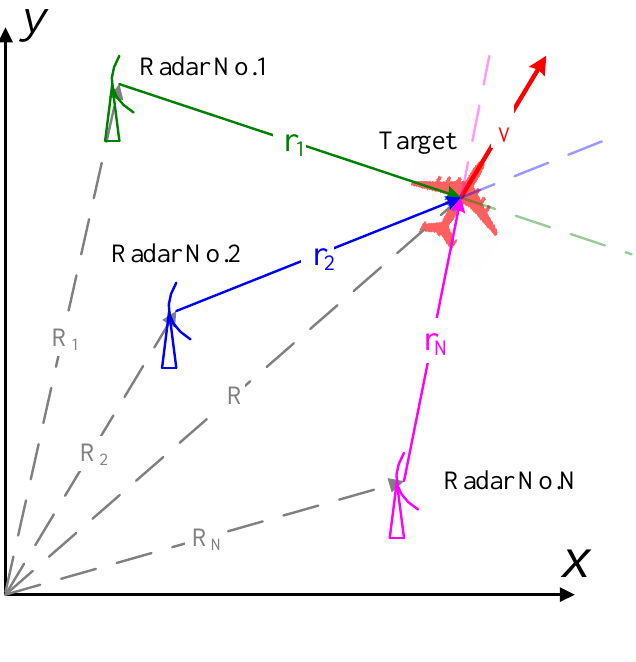
Figure 2. Top view of the cognitive radar network in an x-y coordinate